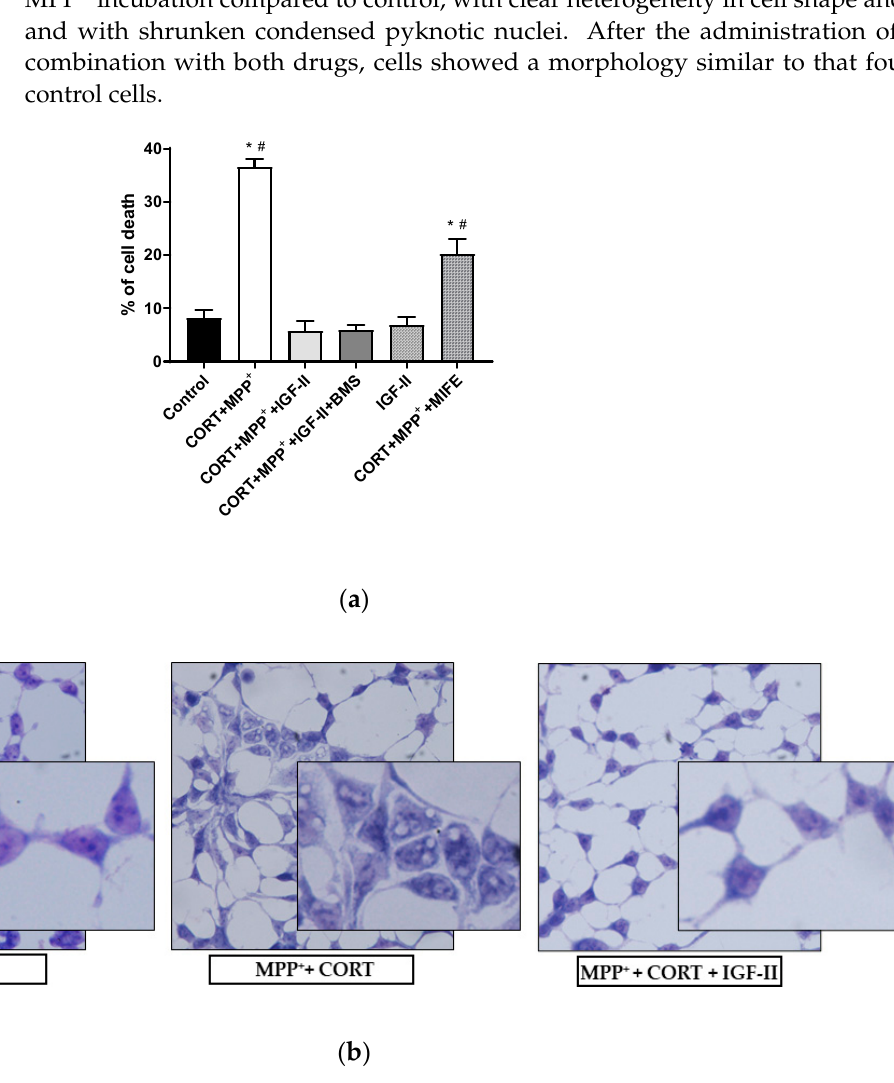
Figure 1. Cell death and morphology of SN4741 neuronal cells after 6 h of incubation with the combination of corticosterone and MPP + (CORT + MPP + ) in the presence or absence of IGF-II. ( a ) Cytotoxicity, measured by quantifying LDH release and expressed as % of control. BMS is used to define the specific receptor involved in the IGF-II effect; MIFE is used to inhibit the glucocorti- coid effect of the CORT. ( b ) Giemsa staining of control cells; CORT + MPP + -treated cells; CORT + MPP + -treated cells in presence of IGF-II. Representative images (20X). Data from four independent experiments were combined and presented as mean ± SEM. * p < 0.05 compared to control cells; # p < 0.05 compared to all other